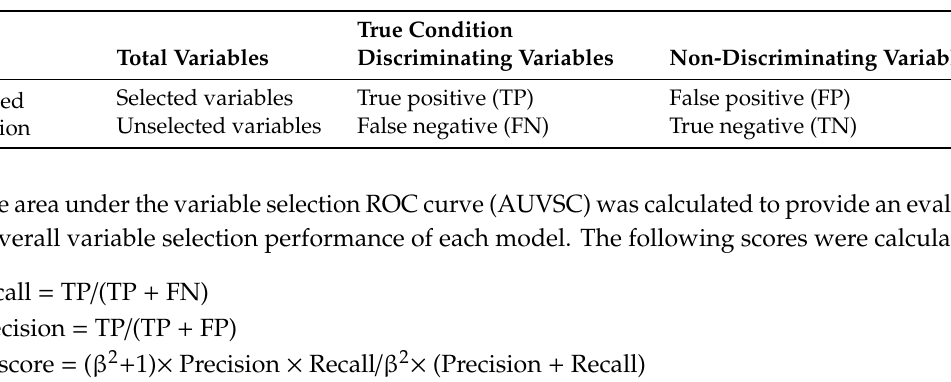
Table 1. Variable selection confusion